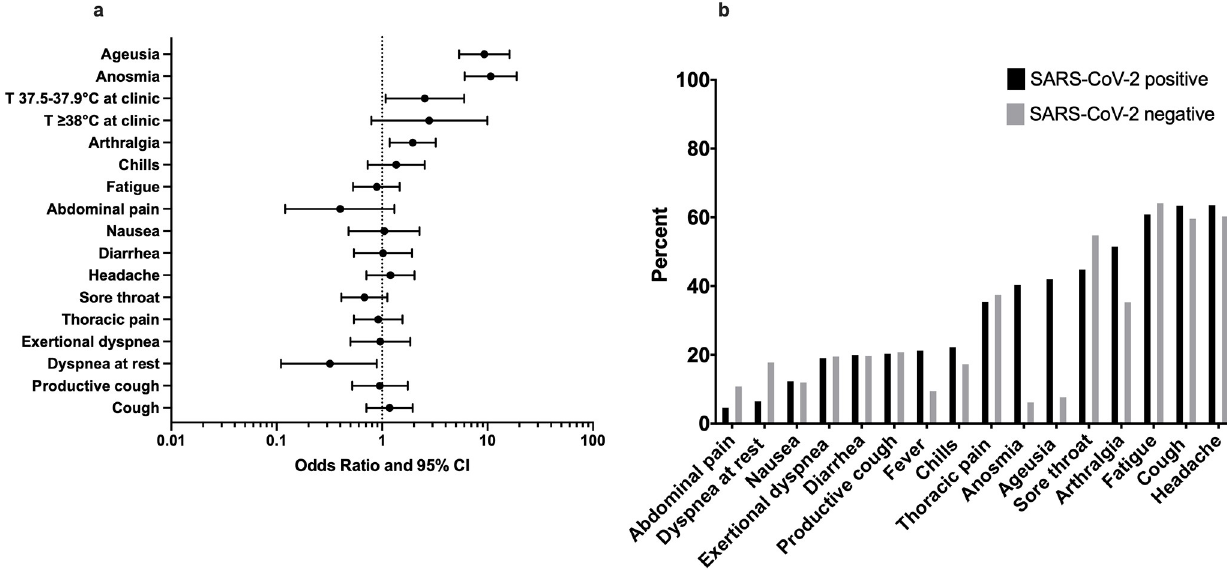
Fig 2. Symptoms as predictors of COVID-19. (A) Fig 2a shows the forest plot depicting the association between symptoms and the risk for COVID-19. The reference group for all symptoms is the group, in which the respective symptom was not present. Fisher’s exact test was used for the calculation. X-axis shows relative increase in risk of COVID-19 as odds ratio. Y-axis denotes individual symptoms. Results are expressed with 95% confidence intervals. (B) Fig 2b shows the relative frequency of individual symptoms in patients with COVID-19 and with other flu-like symptoms. X-axis shows individual symptoms while the Y-axis shows relative frequency in percentage. Abbreviations: T;